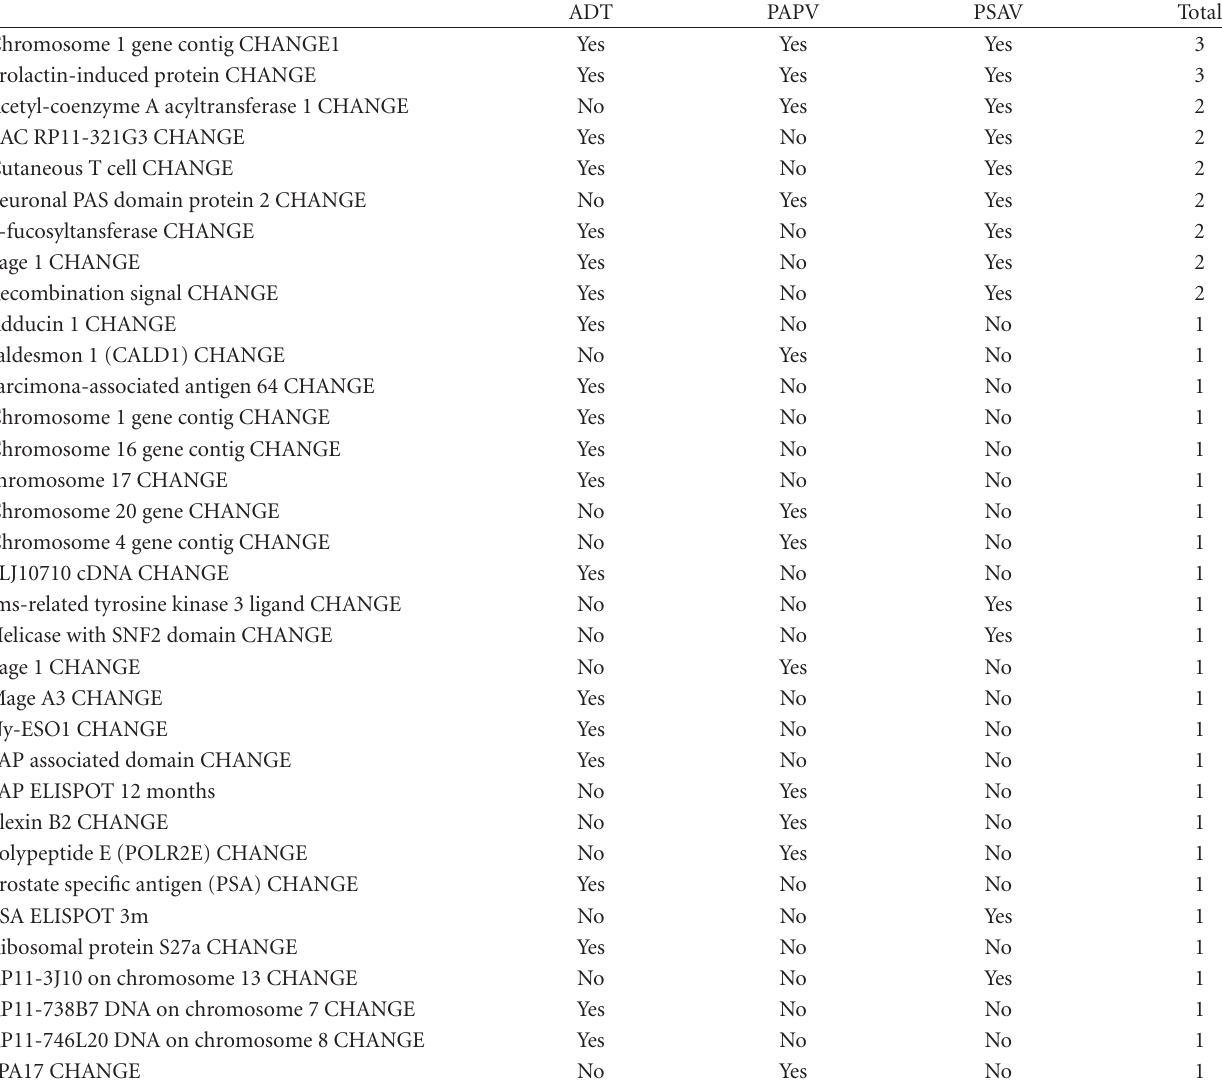
Table 1: Biomarker co-occurrence among models. Feature comparison analysis describing which biomarkers have in population specific ML-BBNs. An IgG response change to Chromosome 1 gene contig CHANGE1, for example, has associations in all three population-specific ML-BBNs. Conversely, an IgG response change to Adducin 1 CHANGE only has an association in the ADT population ML-BBN.